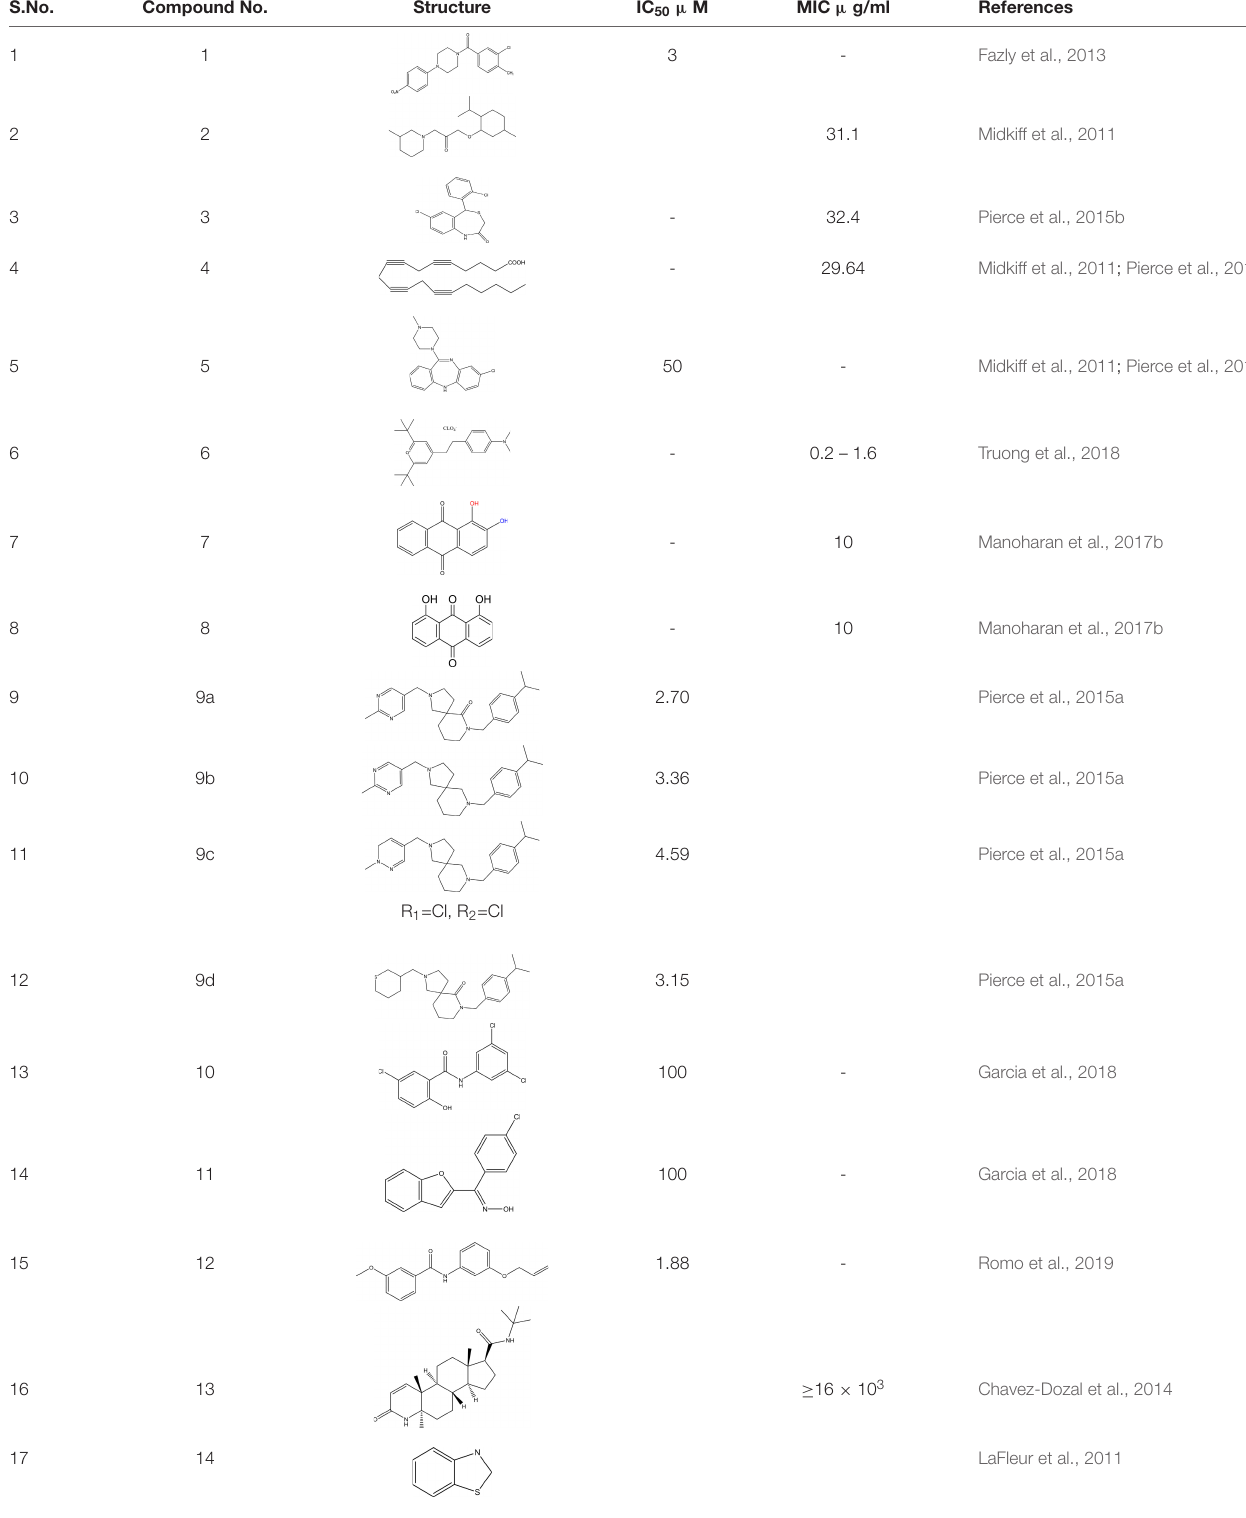
TABLE 1 | Chemical structures and MIC/IC 50 values of small molecule inhibitors (1–22). S.No. Compound